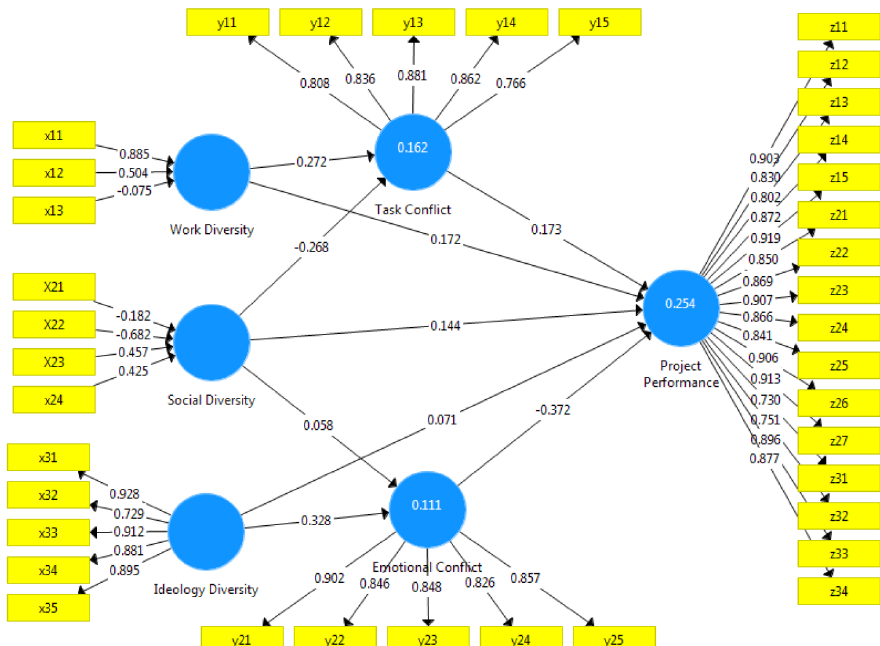
Figure 2. Structural Model from PLS